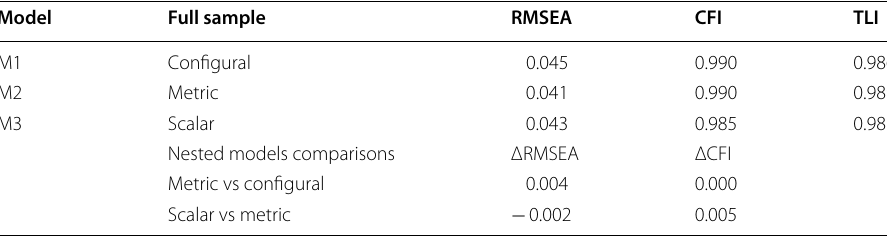
Table 3 Results of multiple-group analysis, overall